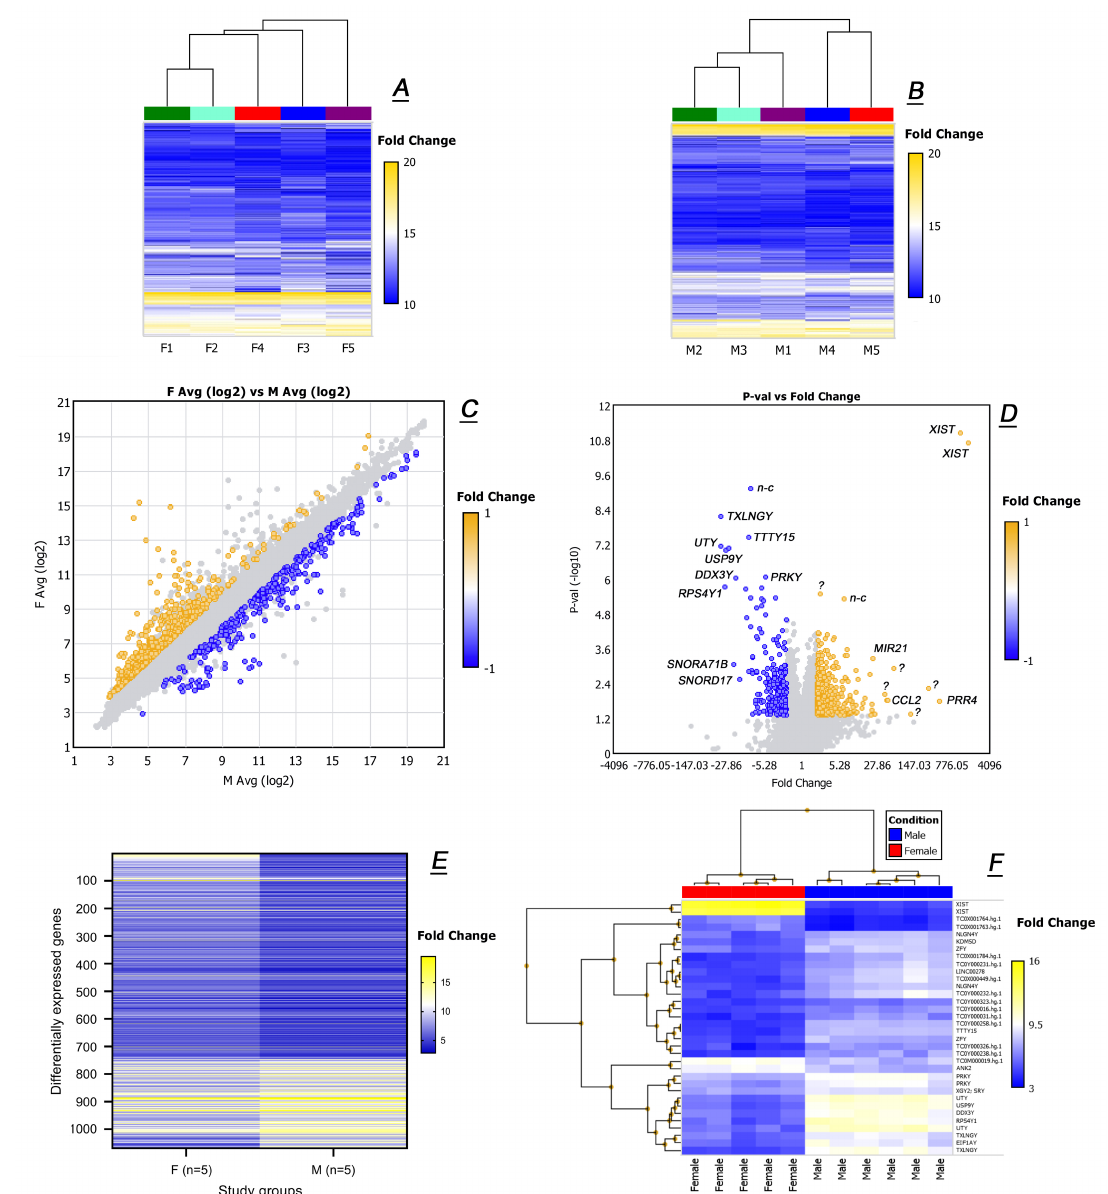
Figure 5. Untargeted transcriptomic analyses of female and male tarsal plates revealed no major intra and inter-group di ff erences in their gene expression patterns except for known gender-specific markers. ( A ) Heat maps of GEP in five female samples F1–F5. ( B ) Heat maps of GEP in five male samples M1–M5. ( C ) A Log2 scatter plot of all genes detected in averaged male ( n = 5; M) and female ( n = 5; F) tarsal plate specimens. ( D ) A “volcano” plot of averaged male ( n = 5) and female ( n = 5) tarsal plate specimens. Note that some genes were of non-protein coding nature (labeled as n-c ). Unknowns are labeled with a question mark (?). Genes with the highest linear fold change and lowest p -value were those with known gender-specific expression patters and no known association with lipid metabolism, except for ACADVL and SMDP3 . ( E ) Side-by-side comparison of more than a thousand genes that are di ff erentially expressed in female (F) and male (M) tarsal plates. ( F ) Heat maps of female and male tarsal plate genes with the highest LFC